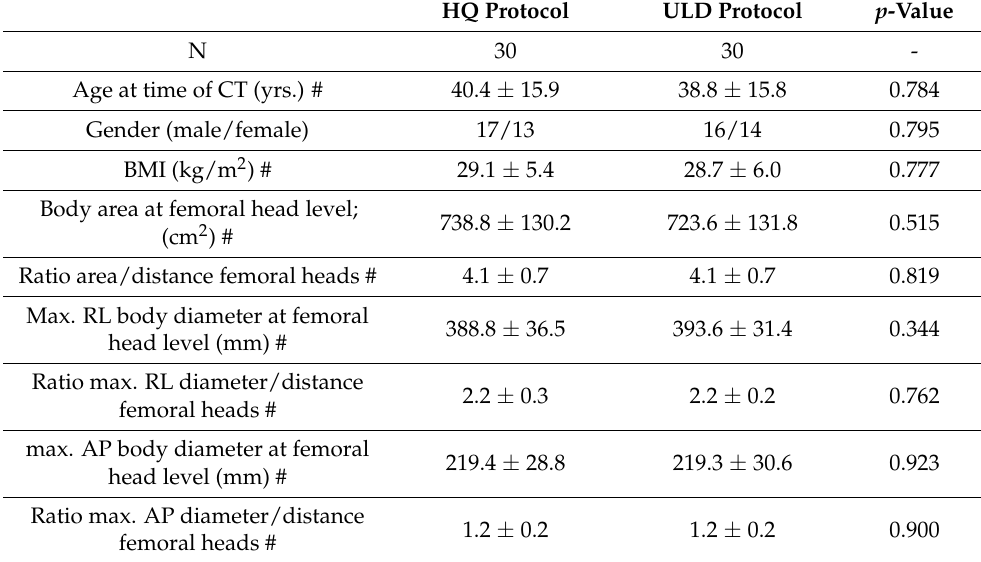
Table 1. Characterization of the population examined with the previous standard HQ study protocol and with the new ULD protocol for CT-torsion measurement of the lower limb.